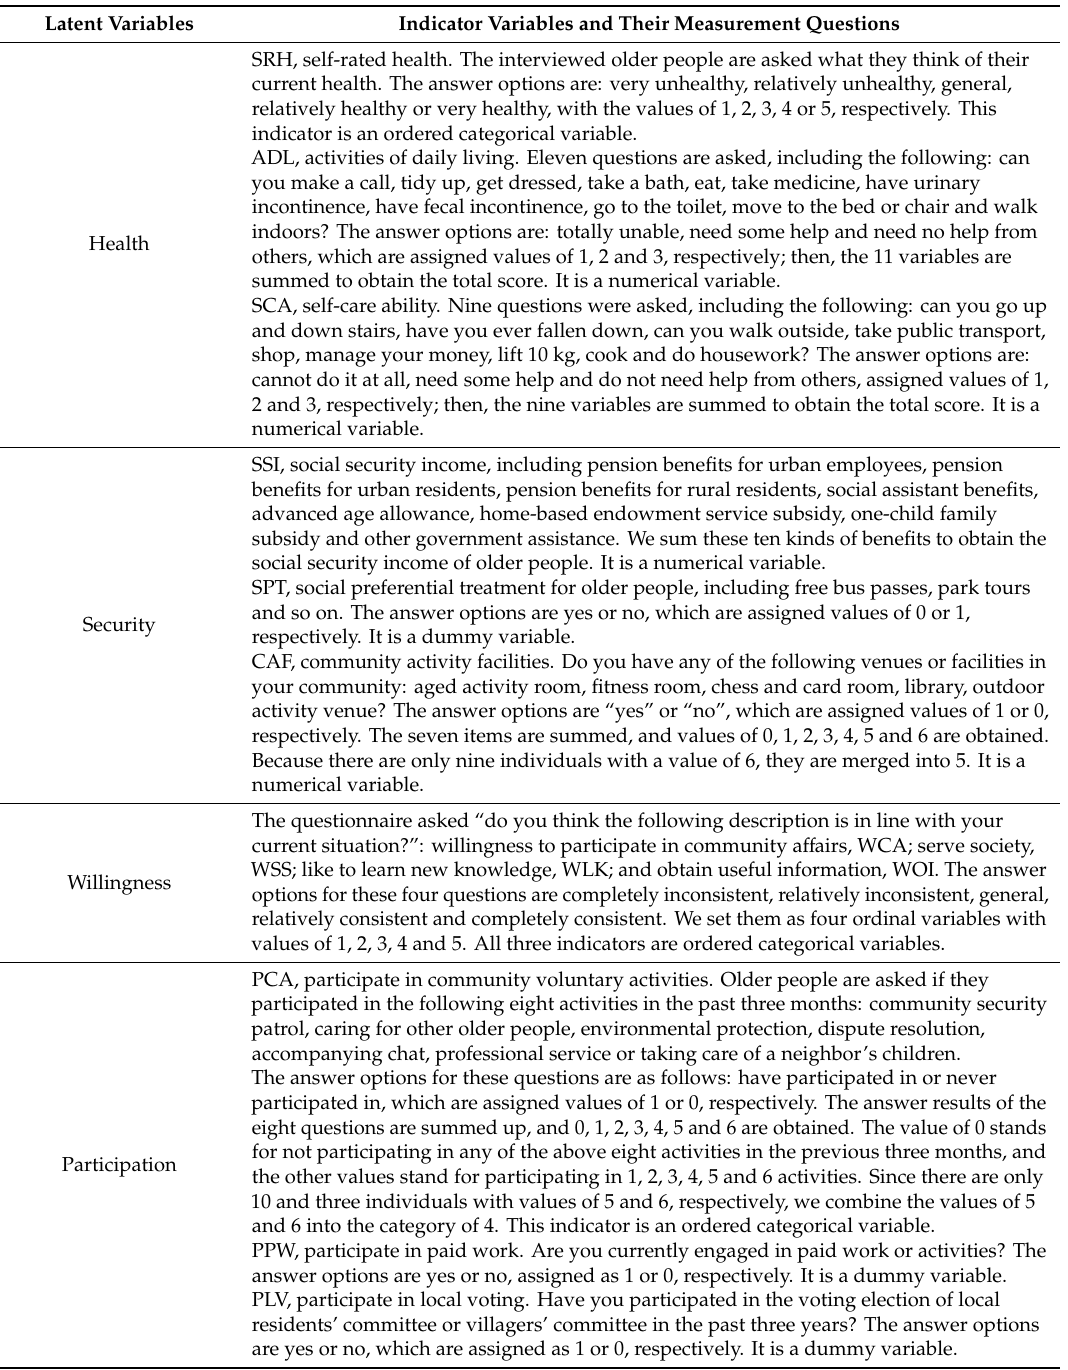
Table 2. Indicators of the latent variables and their measurement